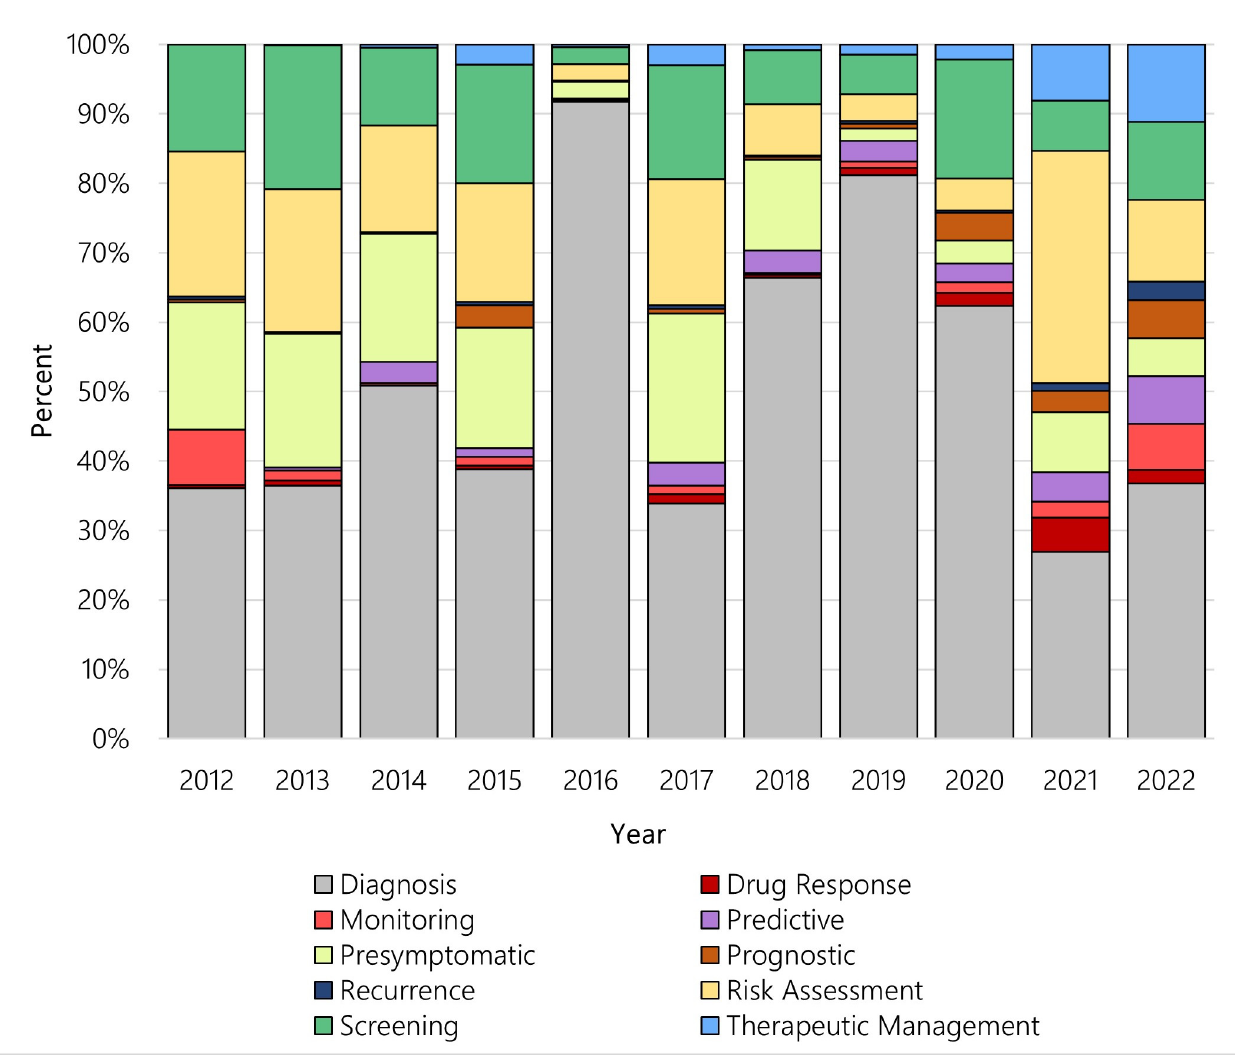
Figure 6. Corresponding category of new genetic tests introduced per year, US.